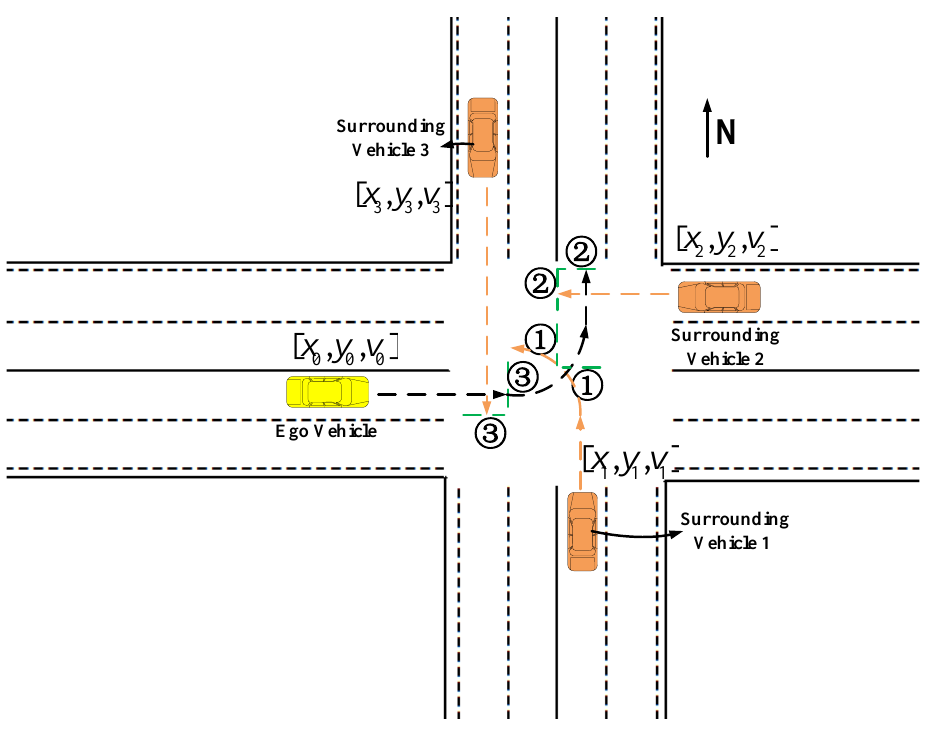
Figure 2. Description of collision relationship between an ego vehicle and multiple surrounding vehicles.